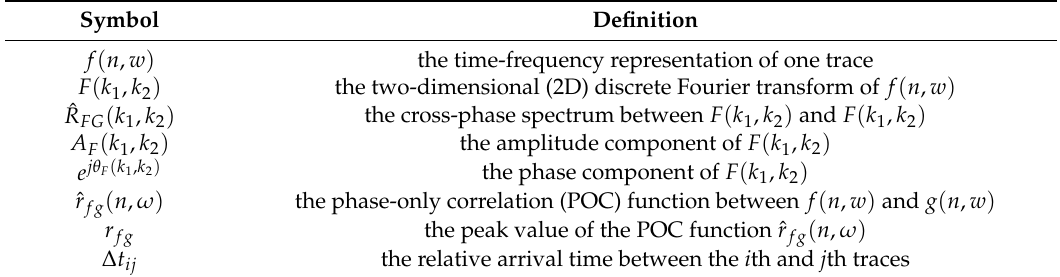
Table 1. Symbols present in this